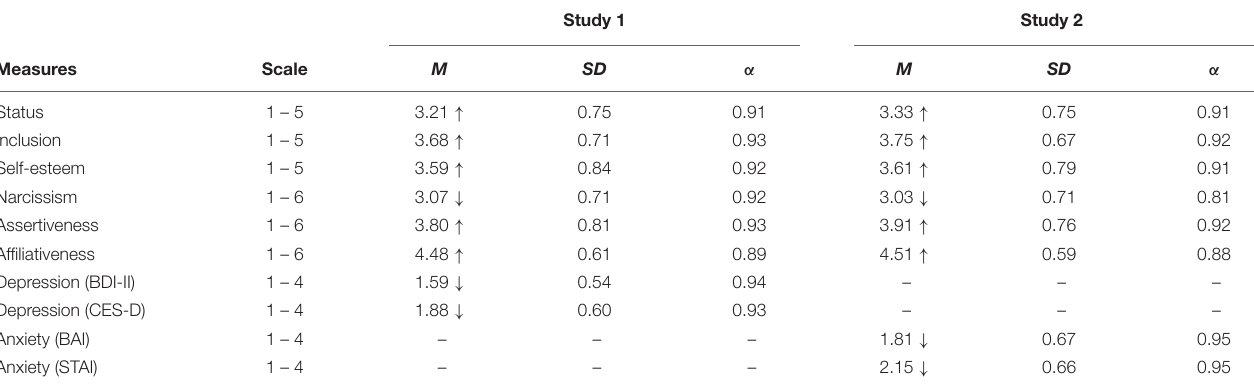
TABLE 2 | Means, standard deviations, and reliabilities of main variables.